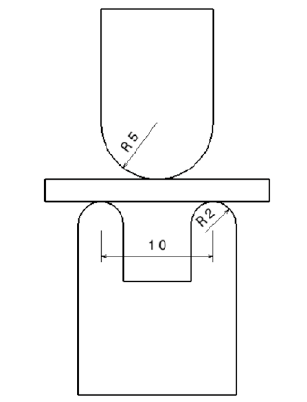
Figure 2: Schematic representation of the short beam